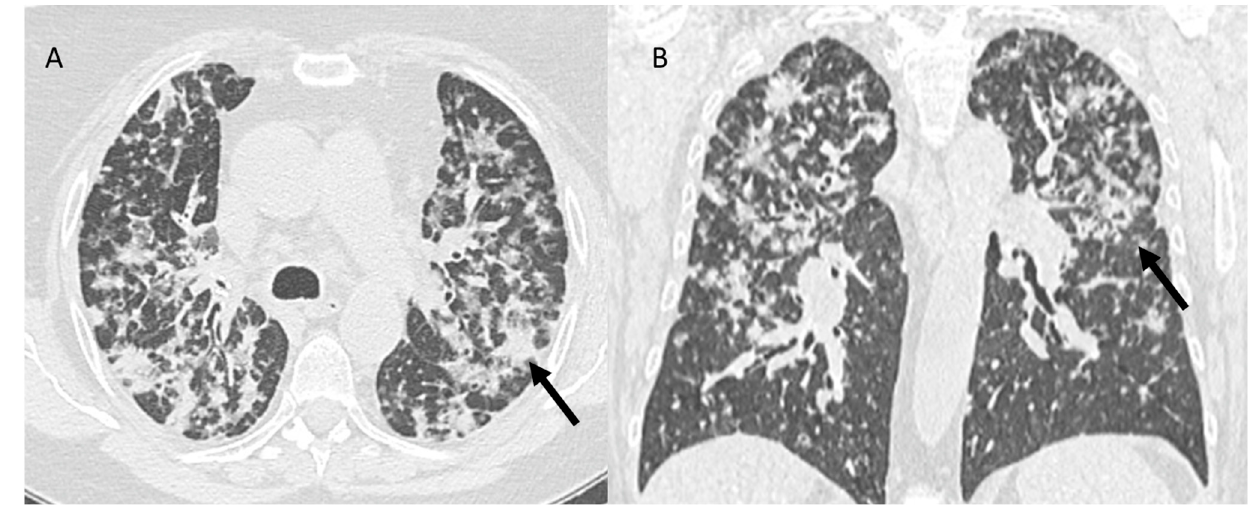
Figure 9. CT assessment (( A ): axial plane; ( B ): coronal plane of PLC in pancreatic cancer patient: irregularly interlobular septal thickening or nodular thickening (arrows).